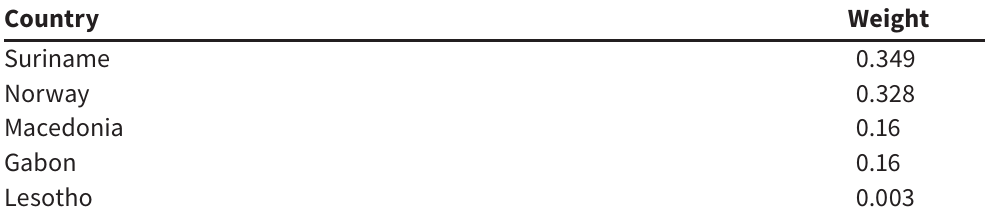
Weights for Constructing Synthetic Puerto Rico Country